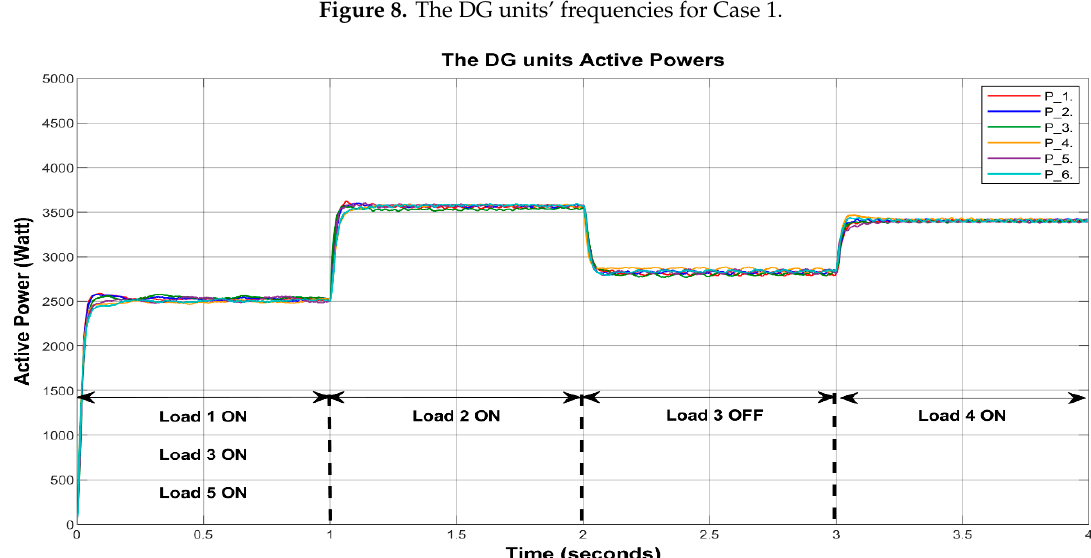
Figure 8. The DG units’ frequencies for Case 1.